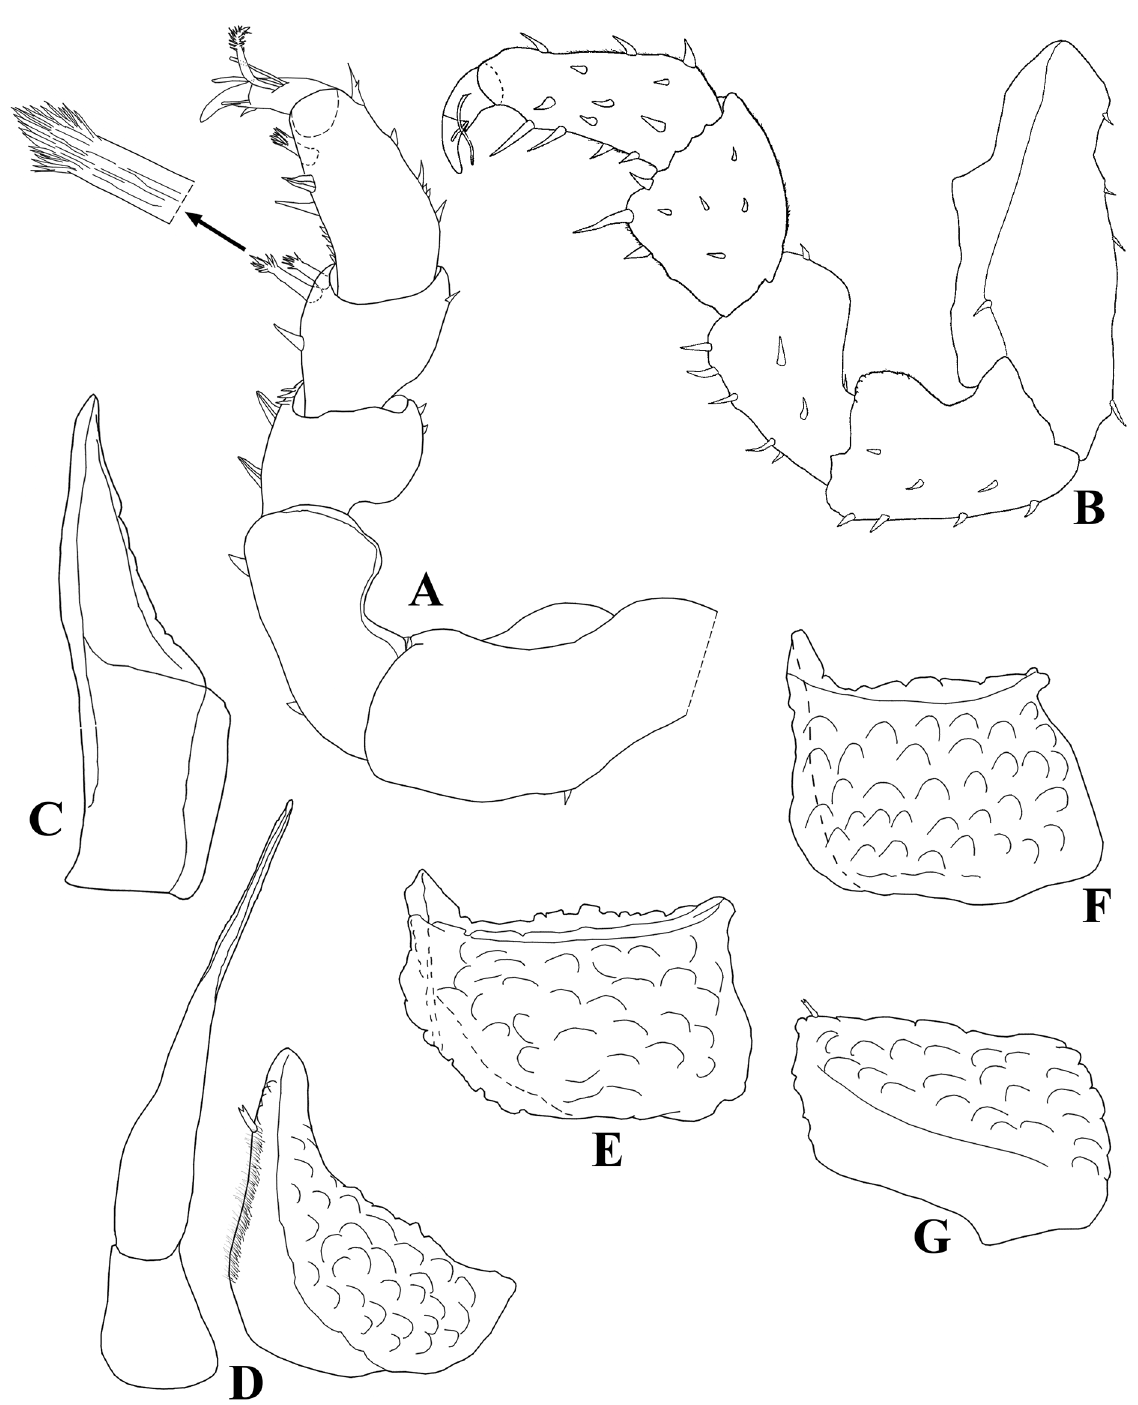
Fig. 8. Stenoniscus nestori López-Orozco, Taiti & Campos-Filho sp. nov., paratypes, ♂♂ (CDUC- CRU 185 and CDUC-CRU 186). A . Pereopod 1. B . Pereopod 7. C . Pleopod 1 endopod. D . Pleopod 2. E . Pleopod 3 exopod. F . Pleopod 4 exopod. G . Pleopod 5